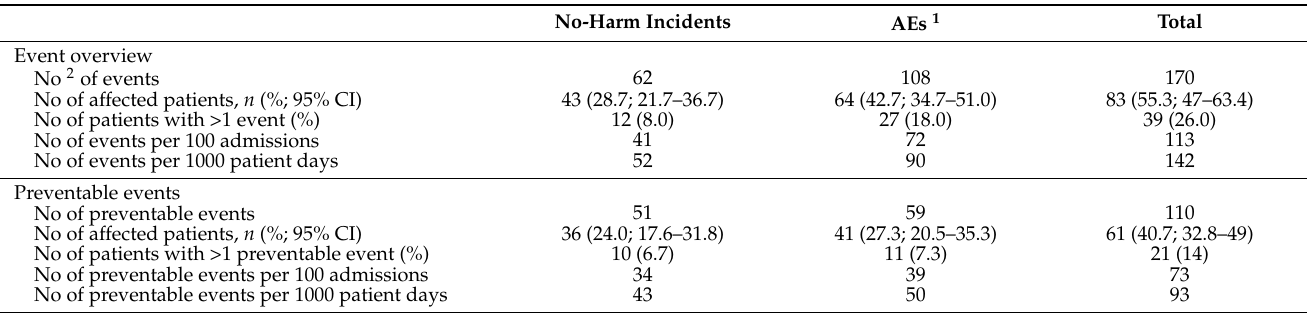
Table 2. Overview of no-harm incidents and AE